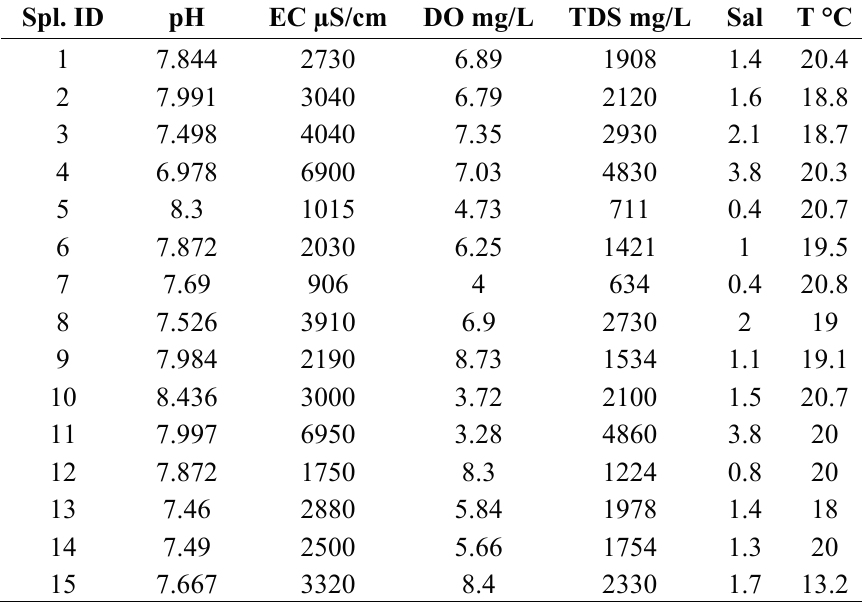
Table A2. Water quality data of 15 groundwater samples taken near Rafaela, Santa Fe province, Argentina (on-site measurements with multi parameter probe (WTW, Multi 3430 SET G, Weilheim,